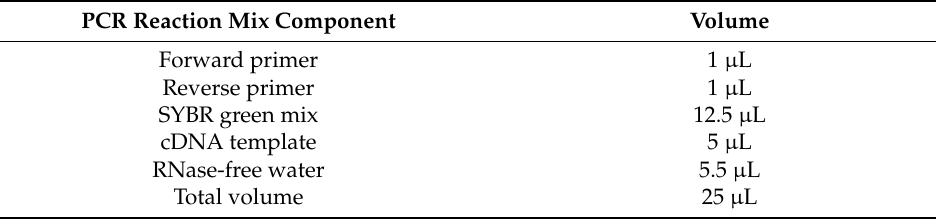
Table 3. Reagents and volumes added.